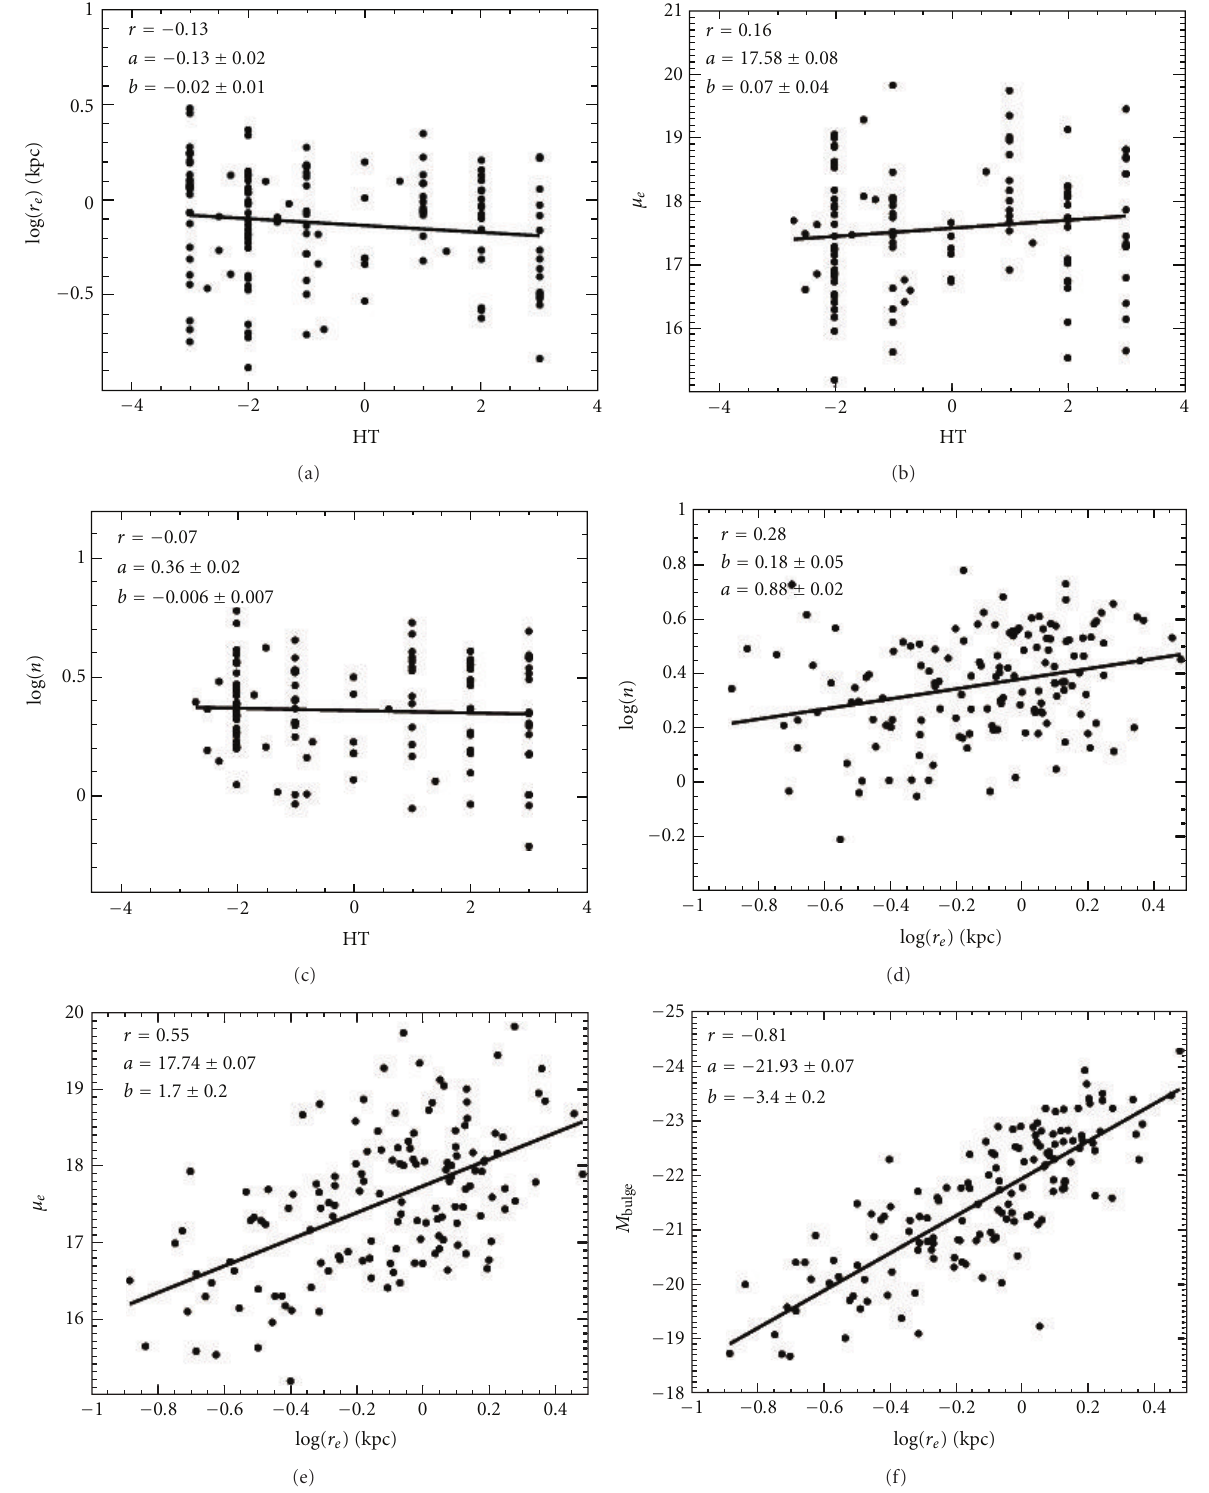
Figure 7: Correlations between the bulge parameters for a sample of lenticulars and early-type spirals. Correlation between the Hubble type and e ff ective radius (a), e ff ective surface brightness (b), and S´ersic parameter (c). Correlations between the e ff ective radius of the bulge and the S´ersic parameter (d), e ff ective surface brightness (e), and absolute magnitude (f). The full line represents the best linear fit. The Pearson correlation coe ffi cient ( r ) is also indicated. See [103] for more